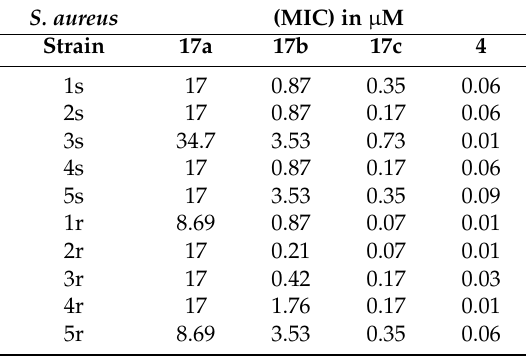
Figure 6 . Structures of derivatives 17a – c and 4 . Table 7. Minimum inhibitory concentration (MIC) in μ M against clinical S. aureus strain susceptible or resistant to methicillin (s: methicillin susceptible strains; r: methicillin resistant strains).